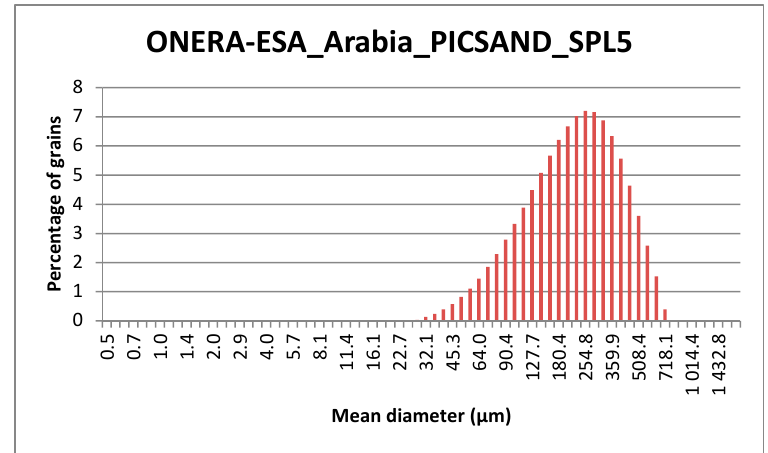
Figure 18. Grain size distribution for the Arabia_PICSAND_SPL5 sample.